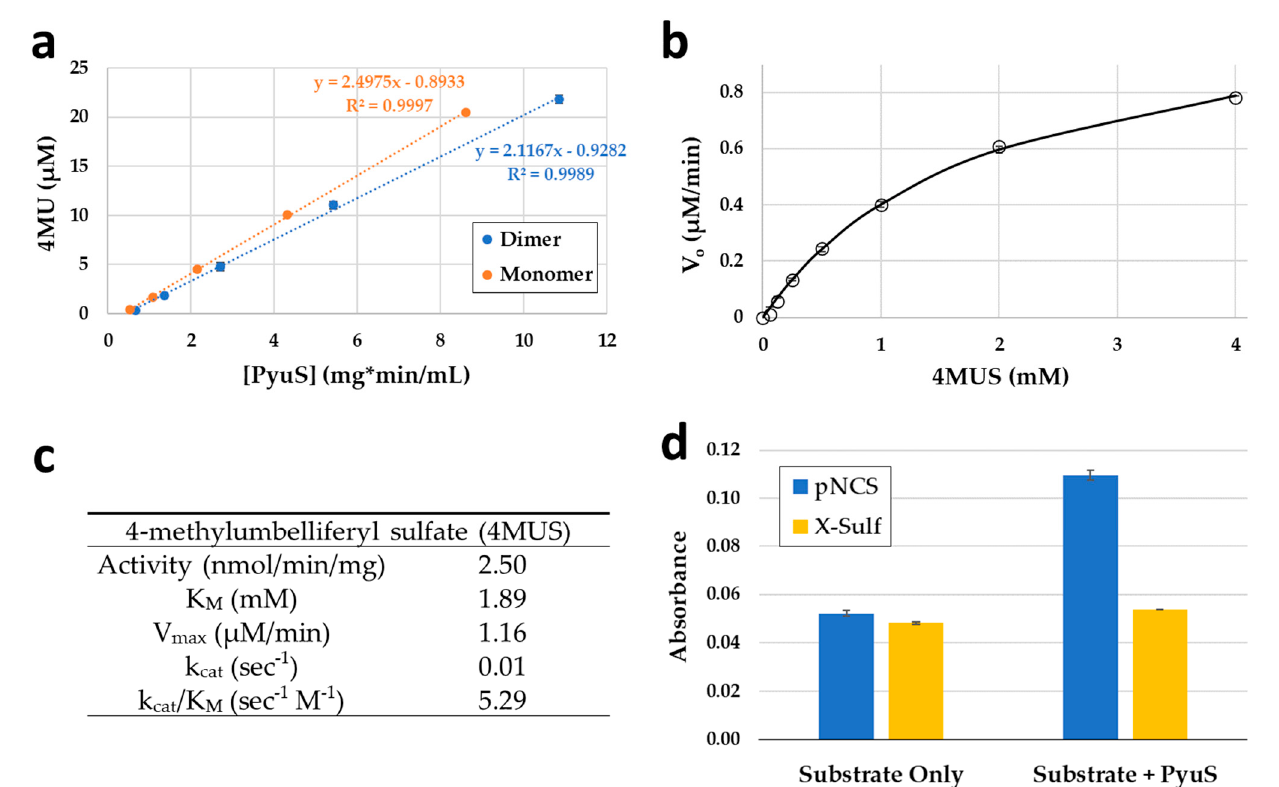
Figure 6 . ( a ) Activity curves of dimeric and monomeric recombinant PyuS on substrate 4MUS. ( b ) Enzyme kinetics curve for 4MUS fit with the Michaelis–Menten equation. ( c ) PyuS kinetic parameters on 4MUS substrate. ( d ) Recombinant PyuS activity on arylsulfatase substrates pNCS and X-Sulf at pH 6.5. The pNCS and X-Sulf products were measured at 515 nm and 650 nm, respectively. Assays were performed with biological replicates.